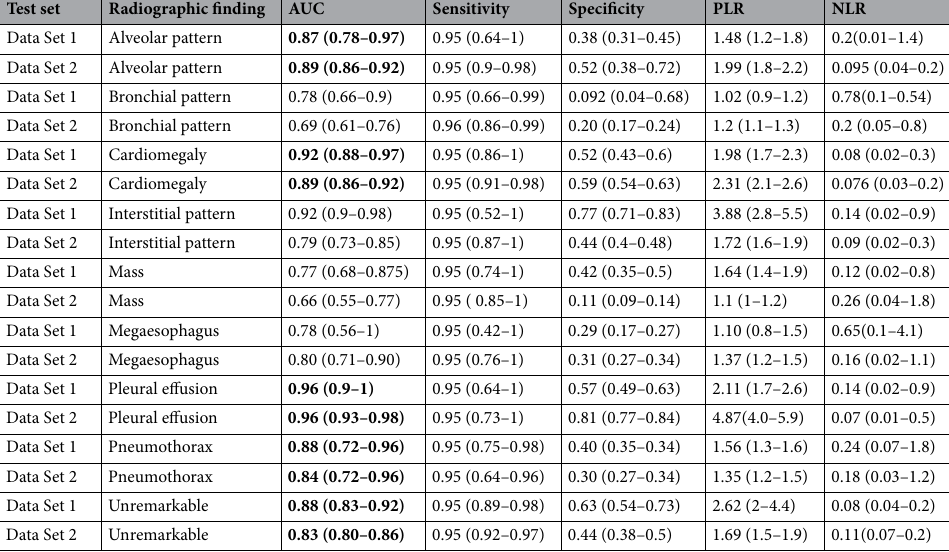
Table 2. Performances of ResNet-50 in Data Set 1 and Data Set 2. Parentheses show 95% CIs. AUC area under the receiver operator curve, PLR positive likelihood ratio, NLR negative likelihood ratio. Most relevant results have been bolded.